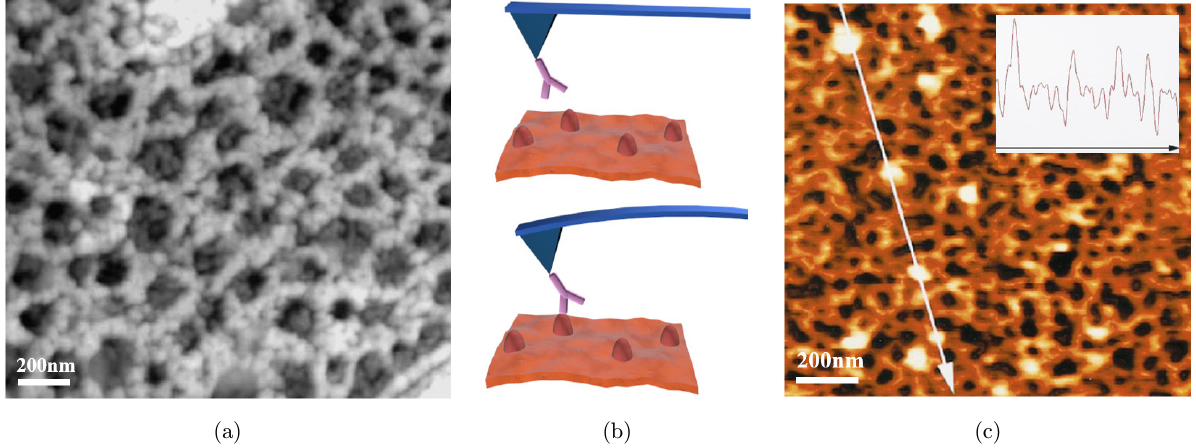
Fig. 6. The ultrastructure of the erythrocyte membrane-skeleton studied by AFM. (a) Two-dimensional overhead view of contact AFM image of a ghost taken from osmotically lysed and air dried un¯xed erythrocytes. (b) Schematic of the principle of antibody recognition imaging by AFM. (c) An AFM image of a ghost membrane-skeleton immunogold labeling with spectrin antibodies. The line indicates the place where the cross section was measured, and passes four particles that are likely to be gold particles. The insert curve is the surface contour along the line. (a) is adapted with permission from Ref. 15 and (c) is adapted with permission from Ref.